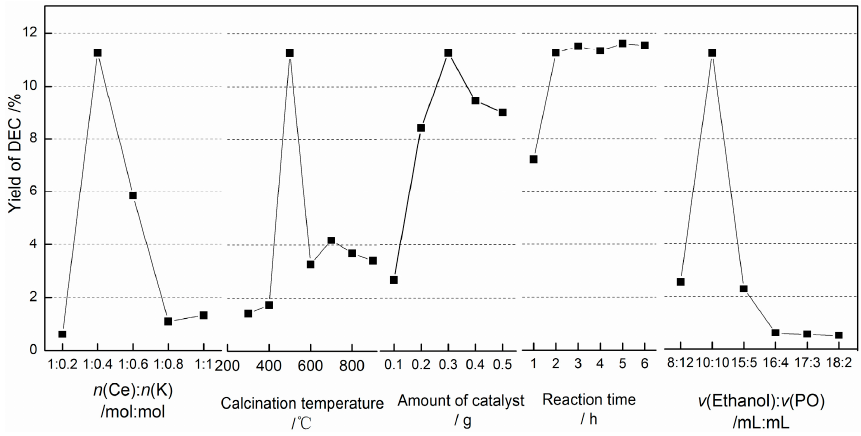
Figure 2. XRD patterns of CeO 2 , KNO 3 ‐ CeO 2 and KBr ‐ KNO 3 ‐ CeO 2 (KBr, CeO 2 ).